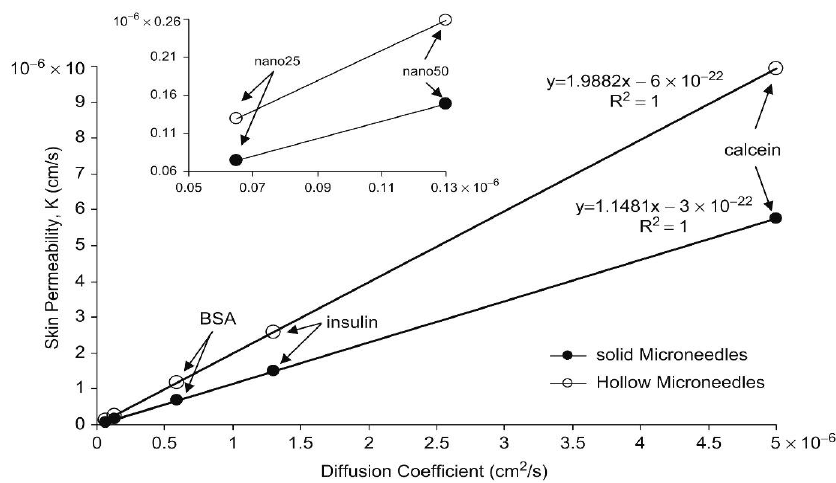
Figure 9. Relationship between the permeability and diffusion coefficient of the optimum solid (n = 20, R = 19 μ m and A = 0.04 cm 2 ) and hollow (n = 13, R = 140 μ m and A = 0.53 cm 2 ) MNs (adopted from [111]).